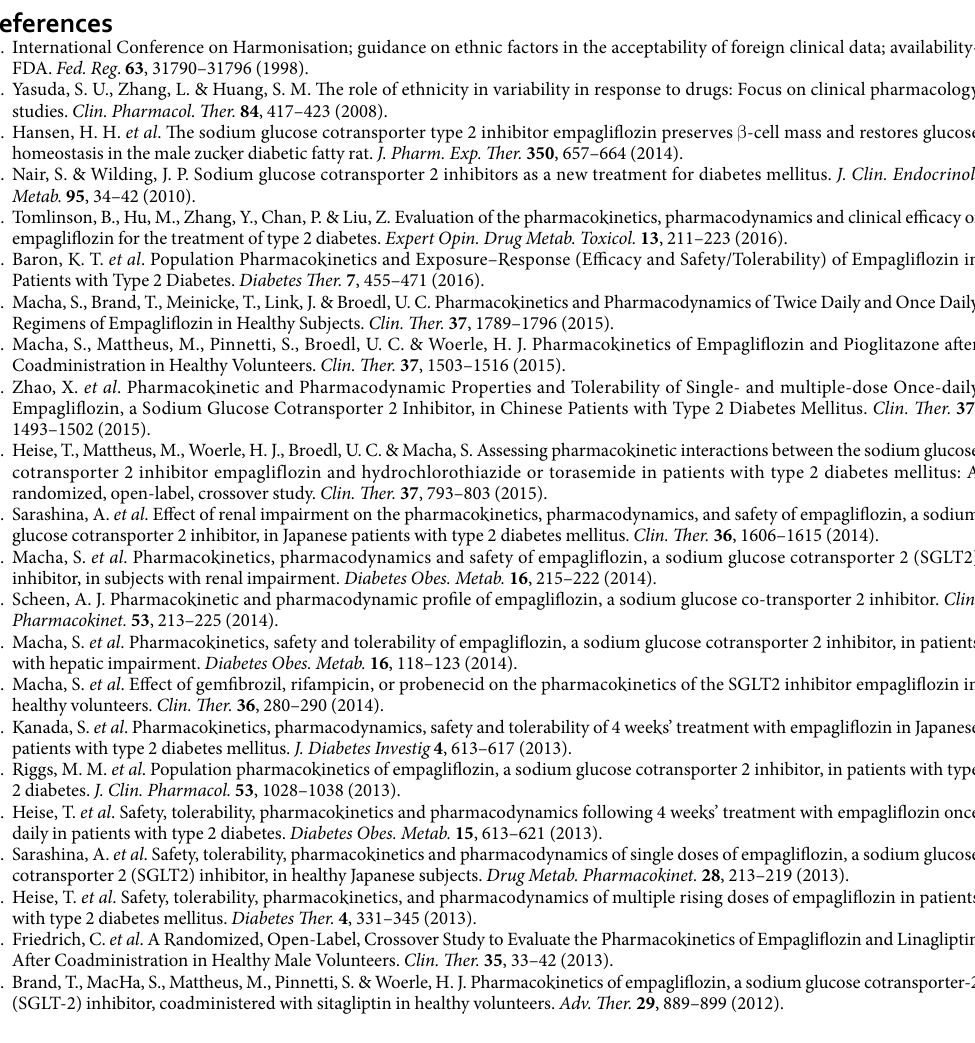
The validated method was proved to be suitable for further toxicodynamic evaluation. The method was applied successfully for the pharmacokinetic study under investigation and owing to the short run time used, rapid anal- ysis of many plasma samples per day was